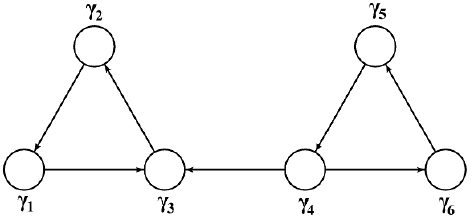
Figure 11. A BPS quiver for ( A 1 ; A 6 ) Argyres-Douglas